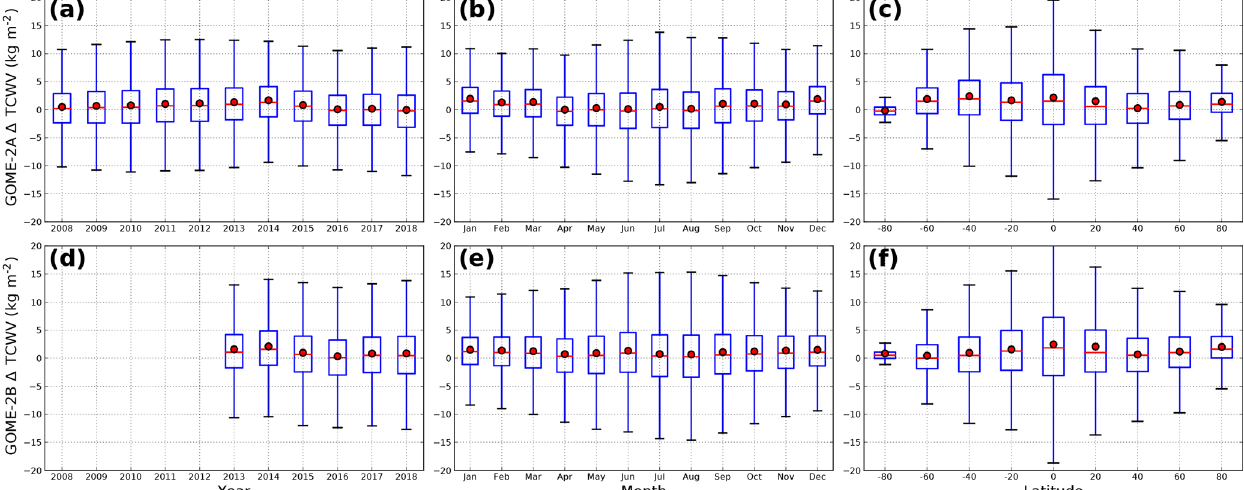
ics, while the variations are much smaller at higher